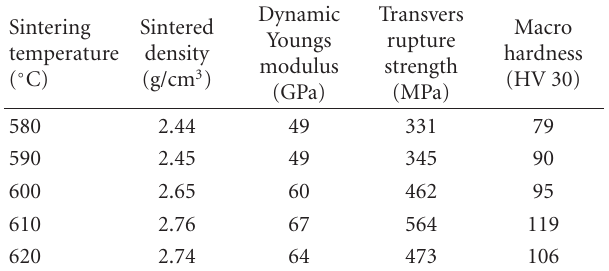
Table 2: Mechanical properties of as-sintered Alumix 431 at di ff erent sintering temperatures (580–620 ◦